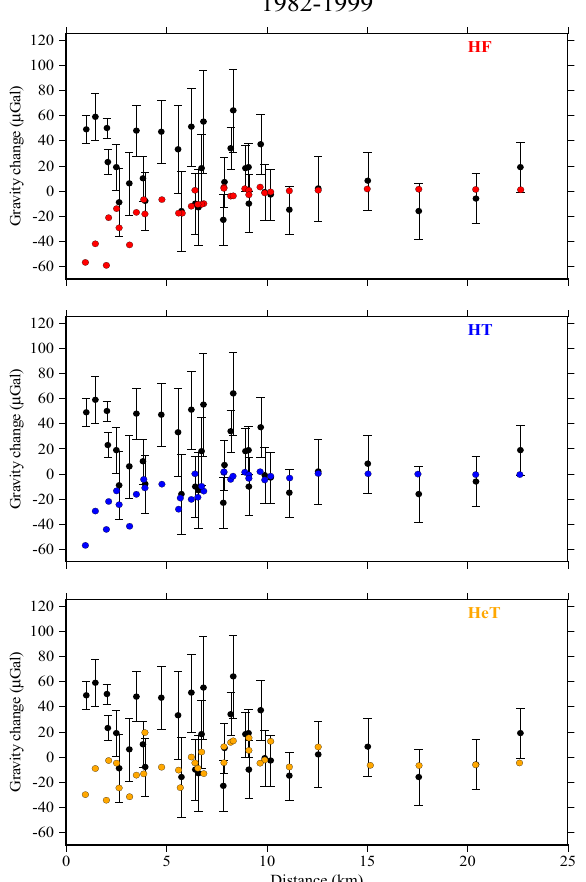
Figure 11. Comparison between observed gravity changes (1982–1999, Table S4, Supplementary Materials) after the removal of free air and water table effect (black circles with 1-sigma error bars) and the total deformation contribution to gravity changes ( δ g 1 + δ g 2 Δ V + δ g 3 ) from the solution of equa- tions (7)–(9) corresponding to different model configurations (colored circles), ordered according to the horizontal distance from the resurgent dome center. HF: homogeneous crust, red circle; HT: homogeneous crust with topography, blue circle; HeT: heterogeneous crust with topography. We then subtract the deformation effects from the observed gravity changes in order to calculate the residual gravity (black circle with error bars in Figure 12). It is worth